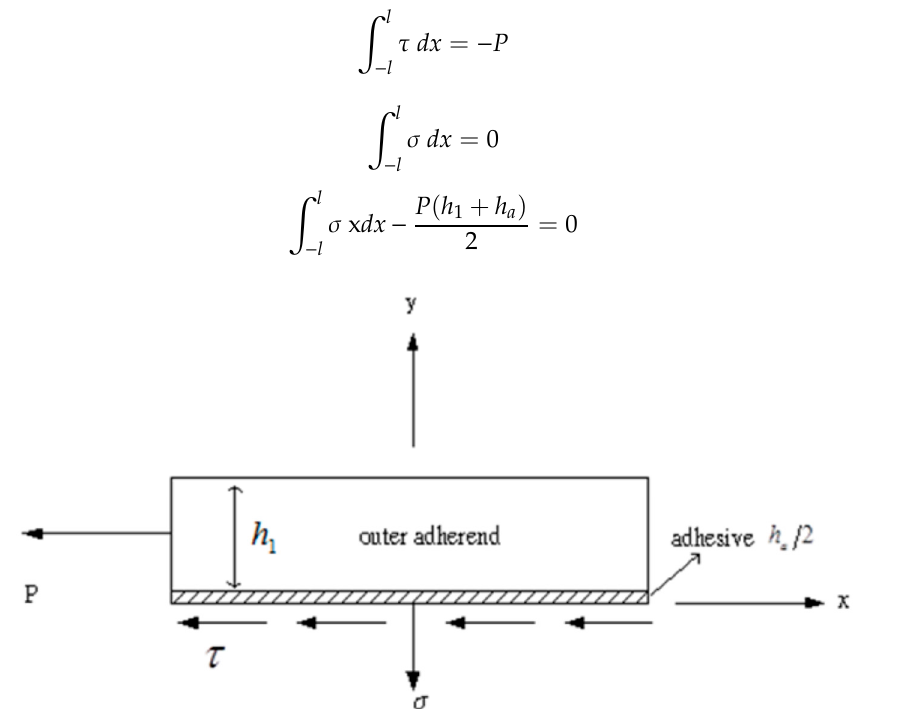
Figure 4. Free body diagram of the overlap region in the outer adherend and adhesive layer.